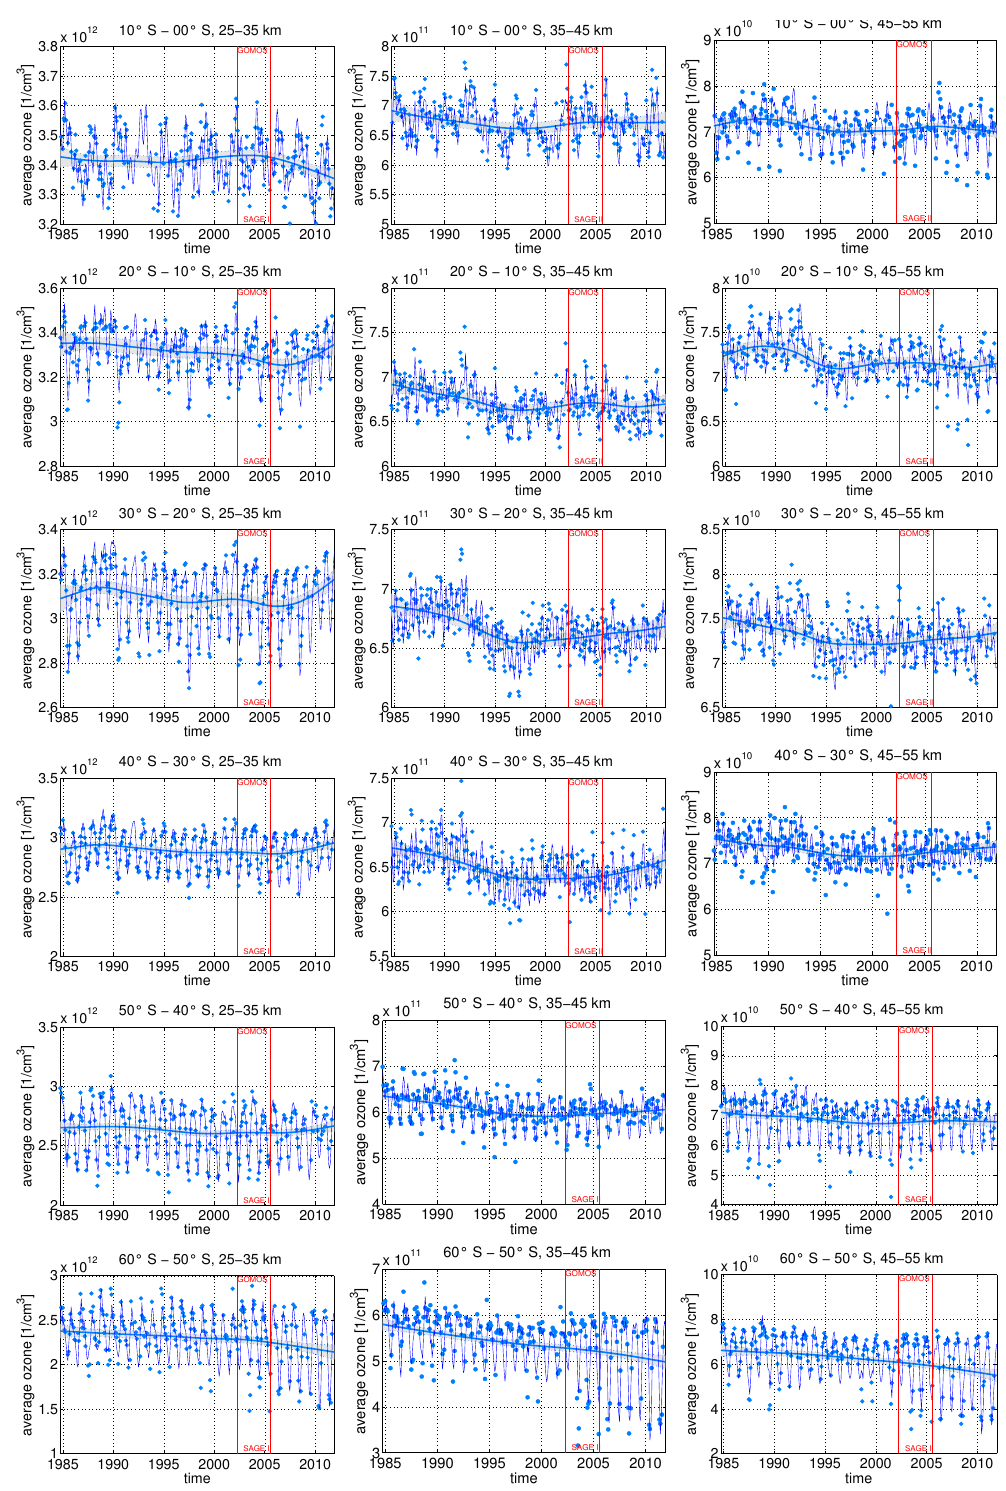
Figure 7. All fits collected for the Southern Hemisphere. The three altitude regions as columns, Southern Hemisphere 10 ◦ zonal bands as rows starting from the equatorial zone. See Fig. 6 for explanation.